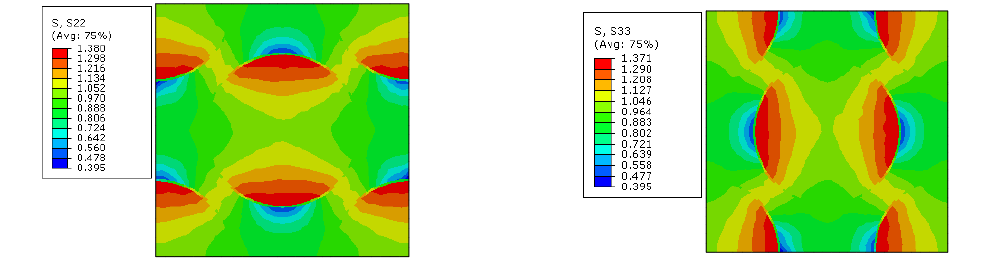
Figure 9. Stress distribution patterns for the model under unit stress loading along transverse direction.